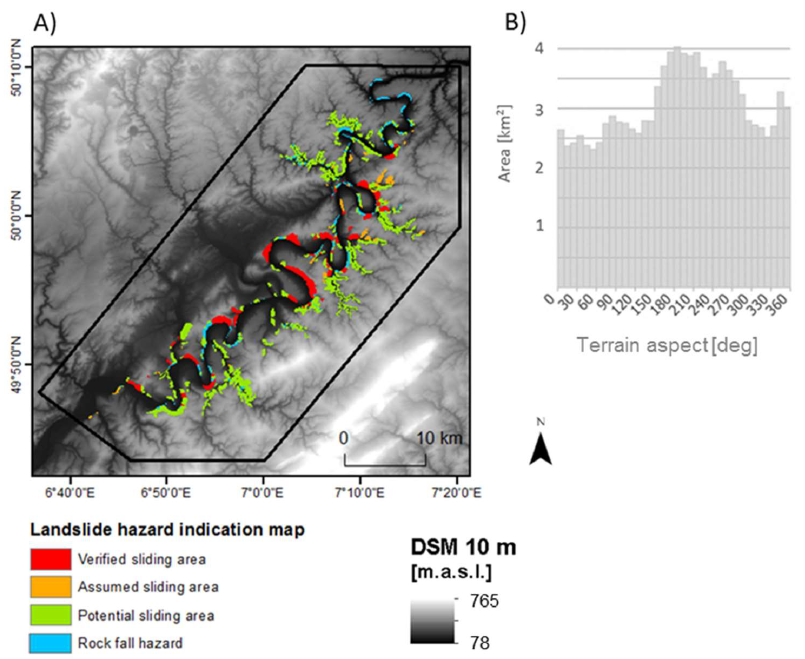
Figure 2. (A) Landslide hazard indication map (modified after [41]). The boundary of the study area is shown by the black outline. A DEM © GeoBasis-DE / BKG 2018 [19] serves as background. (B)